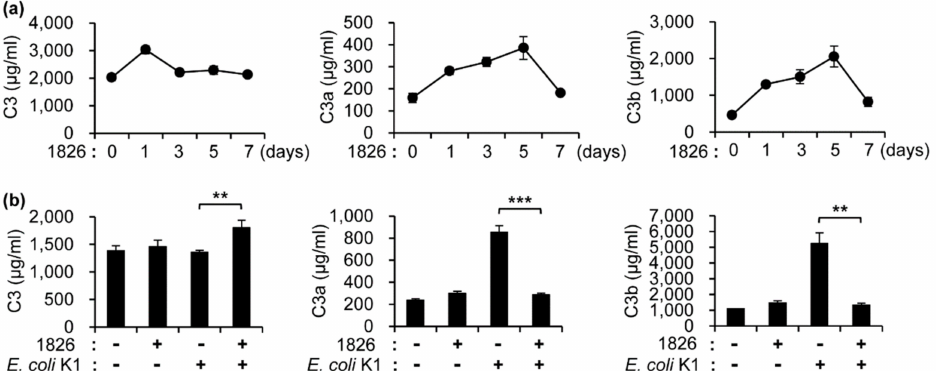
Figure 3. Changes in the complement components after CpG-DNA 1826 and / or E. coli K1 injections. ( a ) BALB / c mice were i.p. injected with CpG-DNA 1826 (2.5 mg / kg mouse). At the indicated time points, the sera were harvested from the mice using the cardiac puncture method, and the levels of the complement components (C3, C3a, and C3b) in the serum were measured using the ELISA kit ( n = 3 / group). ( b ) BALB / c mice were i.p. injected with PBS or CpG-DNA 1826. After seven days, the mice were i.p. injected with PBS or E. coli K1 (1 × 10 6 CFU), and the sera were harvested from the mice using the cardiac puncture method one day after E. coli K1 infection. The levels of the complement components (C3, C3a, and C3b) were measured using ELISA kits ( n = 3 / group). 1826, CpG-DNA 1826. ** p < 0.005, *** p <